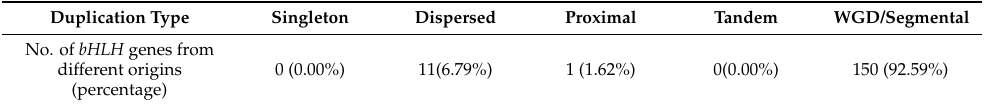
Table 1. Numbers of bHLH genes from different origins in H. hamabo